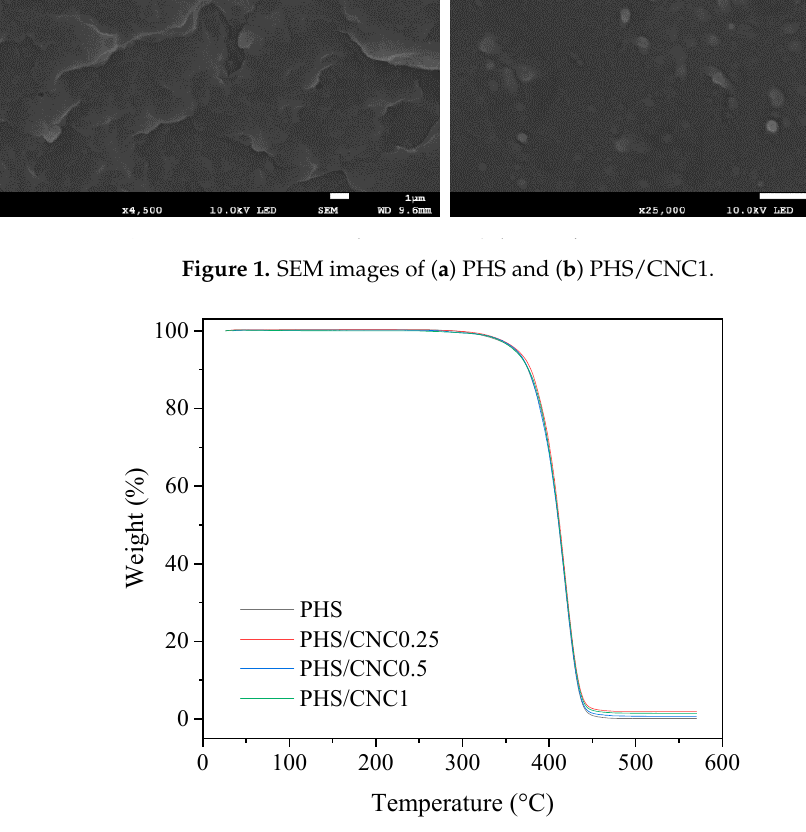
Figure 1. SEM images of ( a ) PHS and ( b ) PHS/CNC1.